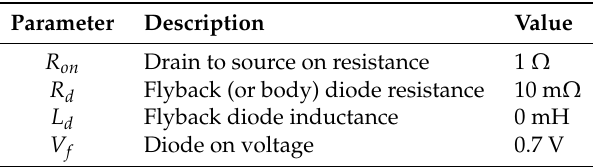
Table 2. Operational parameters of the MOSFET